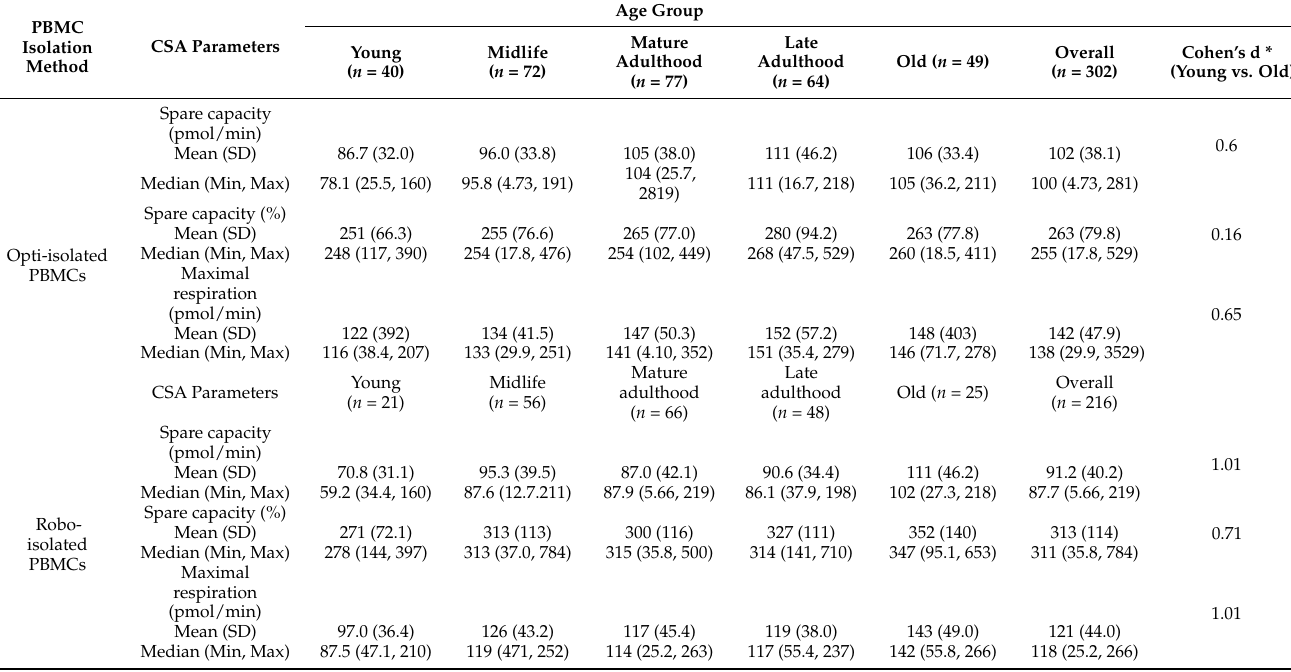
Table 3. Mean, standard deviation and median of spare capacity (pmol/min), spare capacity (%) and maximal respiration (pmol/min) by age group in Opti-isolated PBMCs ( n = 302) and Robo-isolated PBMCs ( n =